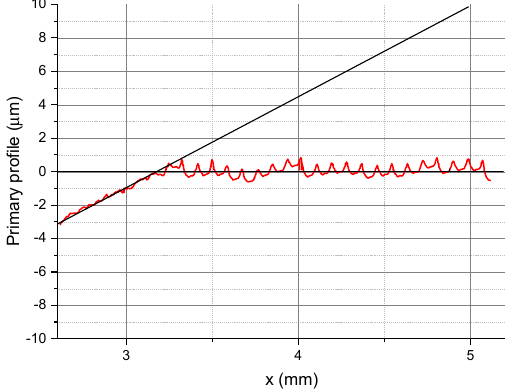
Figure 4. Surface profiles obtained with a contact profilometer for a workpiece machined at v c = 360 m / min, f = 0.09 mm / rev, and r n = 49.9 µ m.